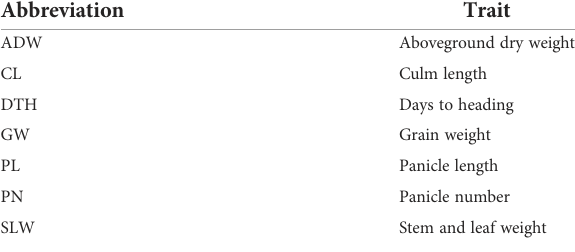
TABLE 1 Traits and their abbreviations.